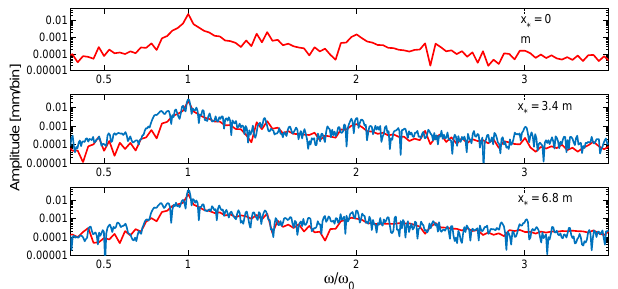
Figure 11. Frequency spectra at selected locations. Red line – nu- merical simulations; blue line – experimental